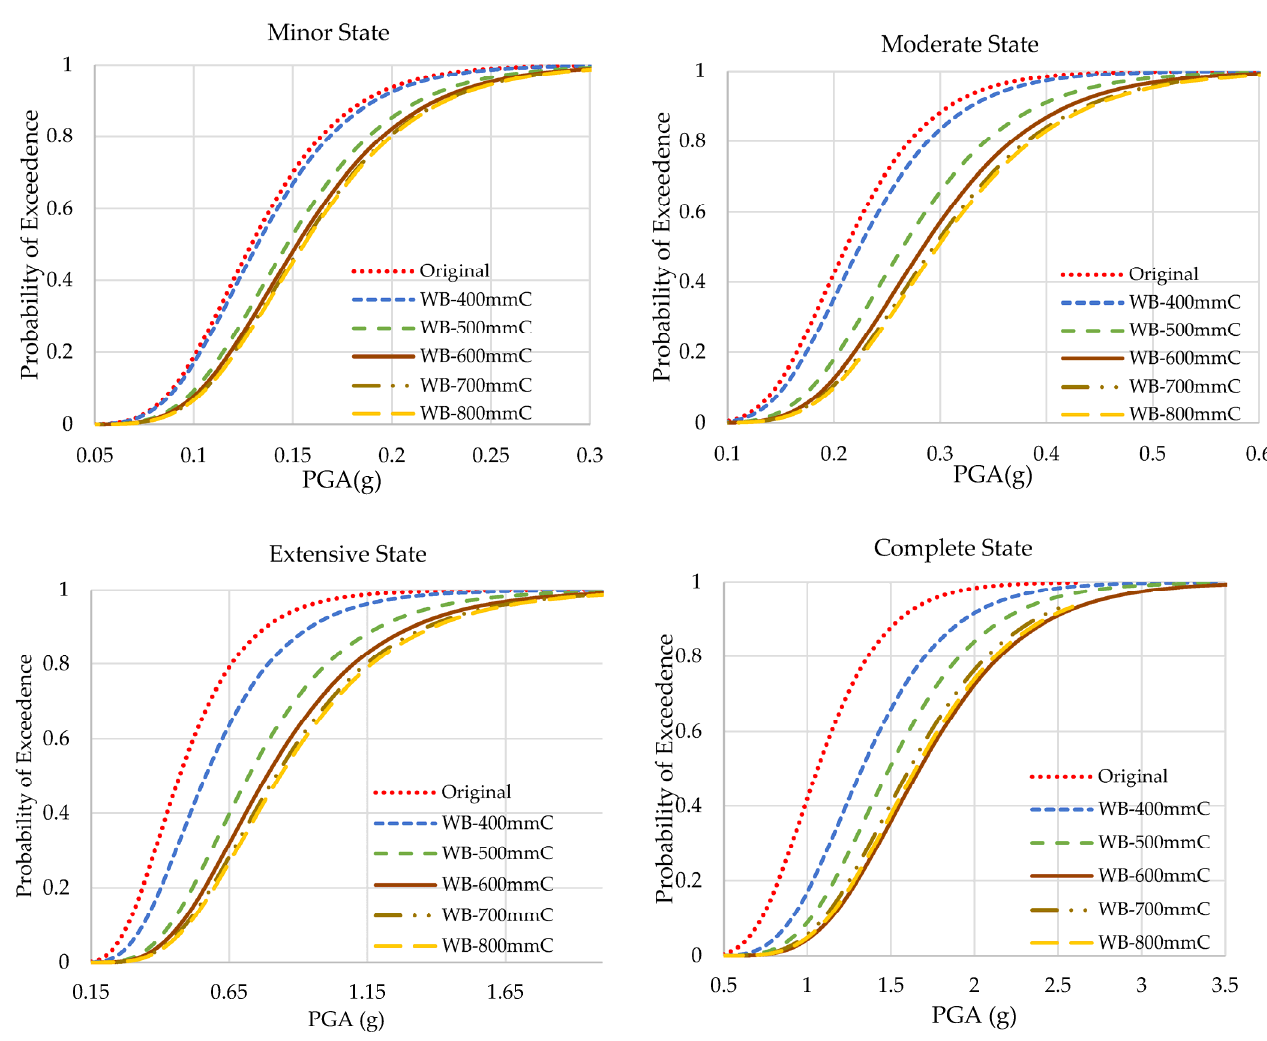
Figure 10. Fragility curves of the original and CFRP web ‐ bonding frames in each state.